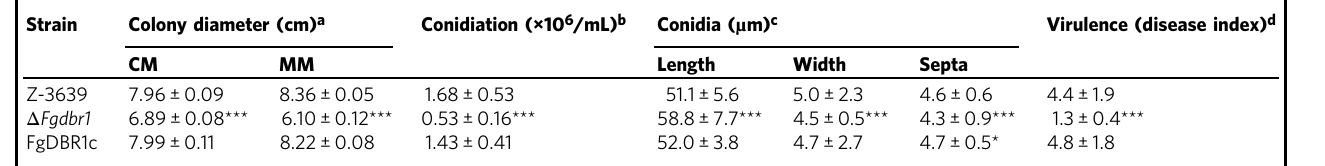
a Colony diameter was measured after 5 days of incubation. b Conidiation was measured by counting the number of conidia produced after 5 days of incubation in CMC medium. c Macroconidia were produced on YMA. In total, 300 macroconidia were examined. d Disease index (number of diseased spikelets per wheat head) for each strain was measured at 21 days after inoculation. Single asterisk represents a signi fi cant difference at p <0.05 according to t -test. Triple asterisks represent signi fi cant differences at p <0.001 according to t